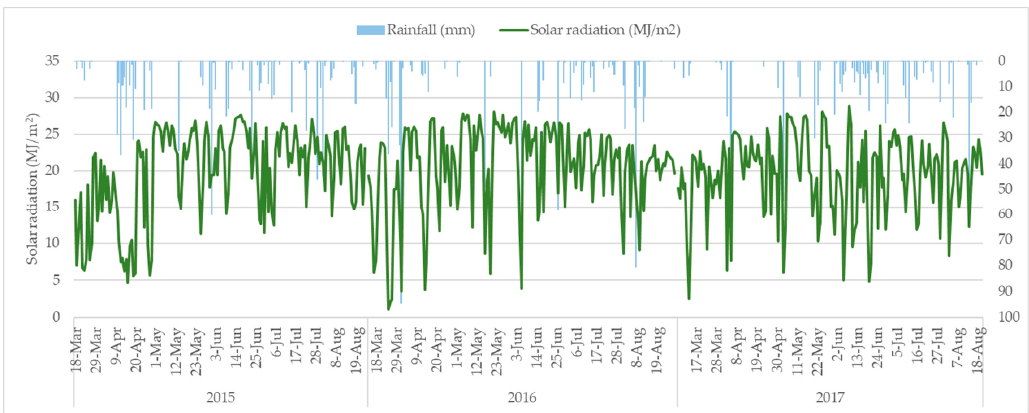
Figure 15. Rainfall (mm) and solar radiation (MJ/m 2 ) in the area of Camilla, GA, where SIRP field is located during the maize growing seasons of 2015, 2016, and 2017.